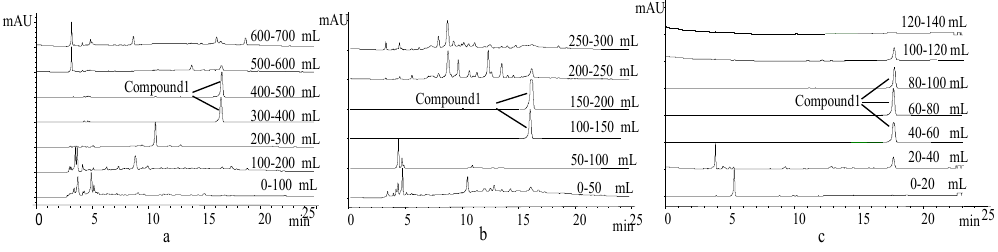
Figure 2. HPLC chromatogram of eluates obtained from column chromatography: ( a ) d = 7 cm; ( b ) d = 5.5 cm; ( c ) d = 3 cm. d : diameter.